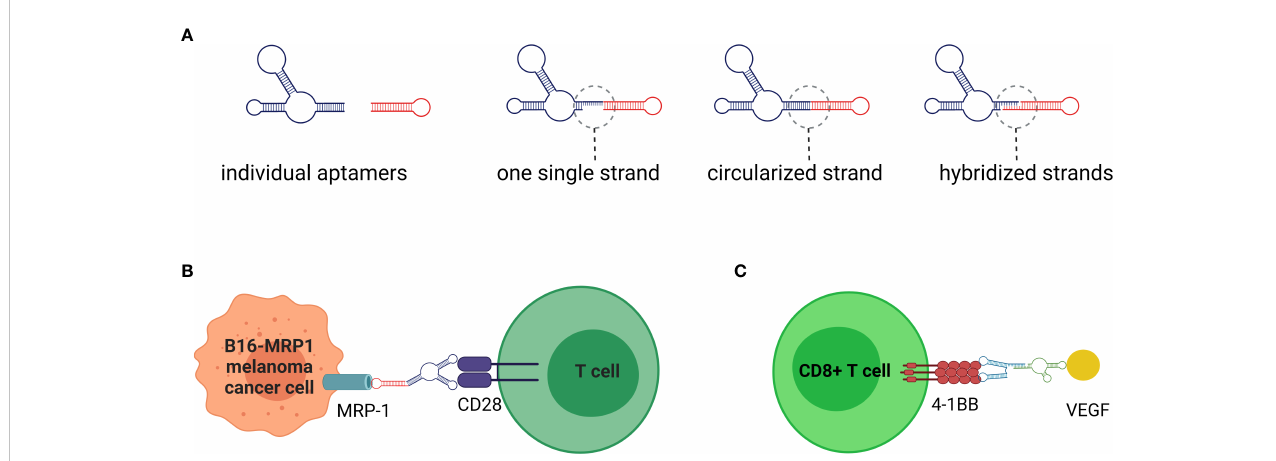
FIGURE 4 Aptamers are nucleic acids selected to speci fi cally bind the molecules of interest in a similar manner to monoclonal antibodies. (A) Nanotechnology offers signi fi cant advantages in fusing individual aptamers to multivalent or bispeci fi c molecules. Thus, by linking together the same or different aptamers, the increased binding af fi nity and/or ability to crosslink target cell receptors can be achieved. (B) Bispeci fi c aptamers can promote cell-to-cell interactions with potential immunomodulatory applications. For example, a single stranded bispeci fi c aptamer targeting CD28 on T cells and Multidrug- Resistant-associated Protein 1 (MRP1), involved in chemotherapy on B16 melanoma cancer cells, has been used to provide the necessary co-stimulatory signal for T cell activation. (C) Instead of cell membrane receptors that may be quickly internalized, an alternative strategy could be to target co- stimulatory signals to proteins (e.g., VEGF) overexpressed on tumor